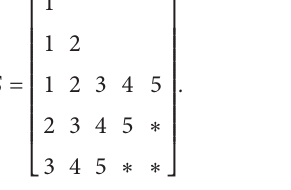
Figure 1: Flowchart of